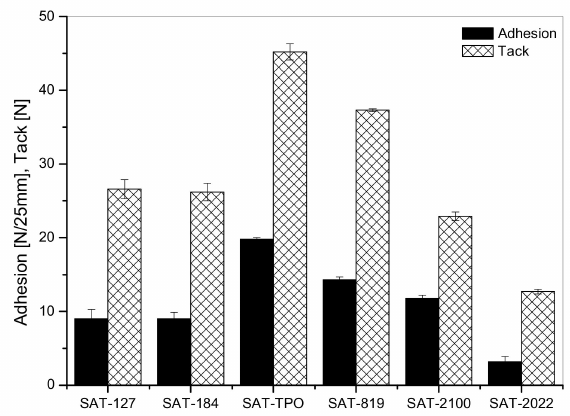
Figure 5. Adhesion to steel and tack for thermally uncured SATs based on